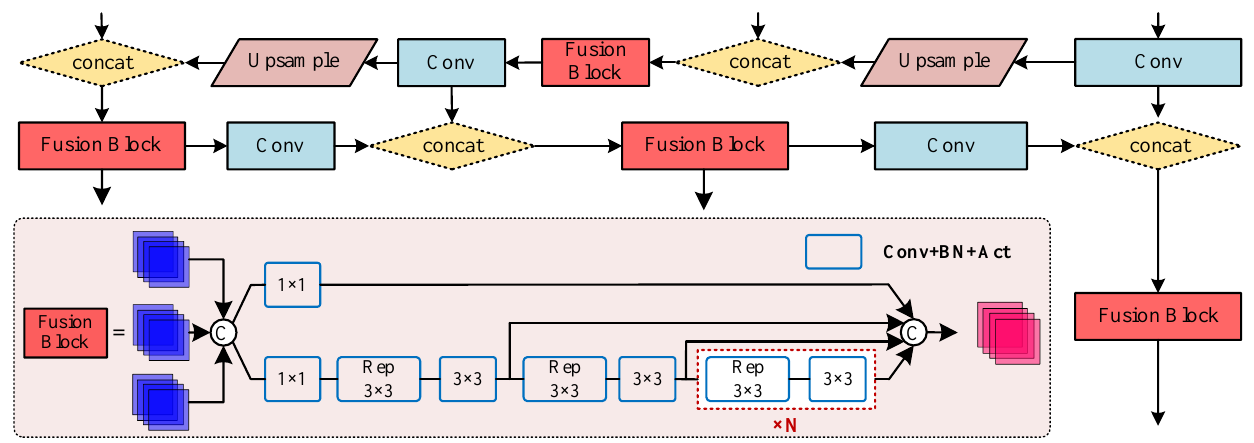
Figure 8. Structure of RepGFPN Neck.